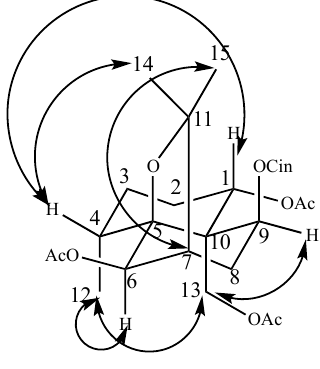
Figure 3. Key NOESY correlation of Compound 1 .